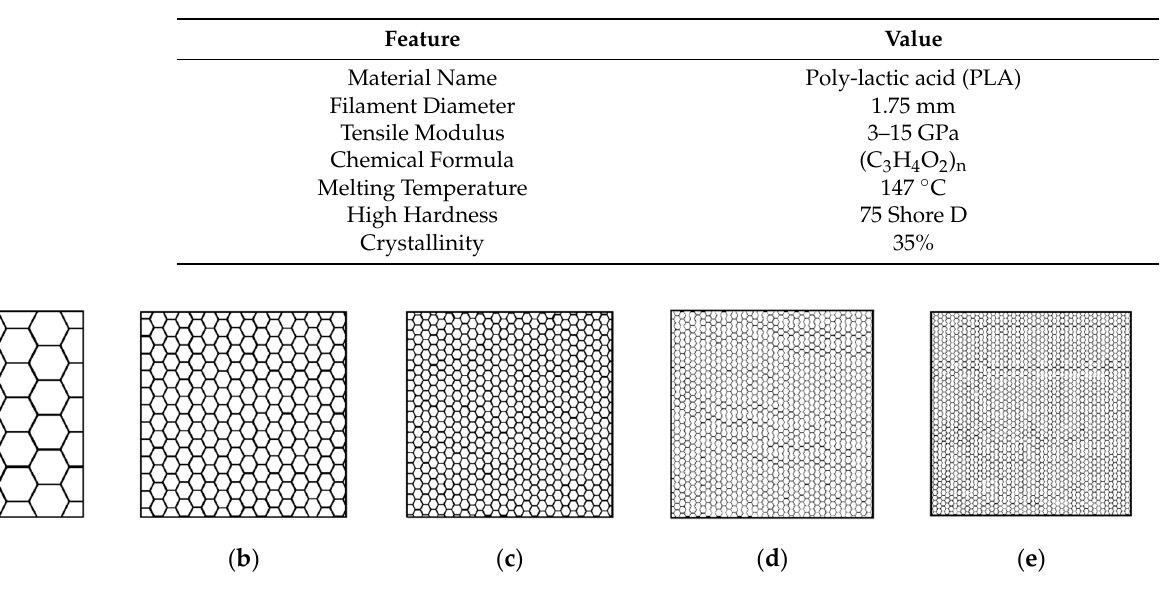
Table 3. PLA material properties.